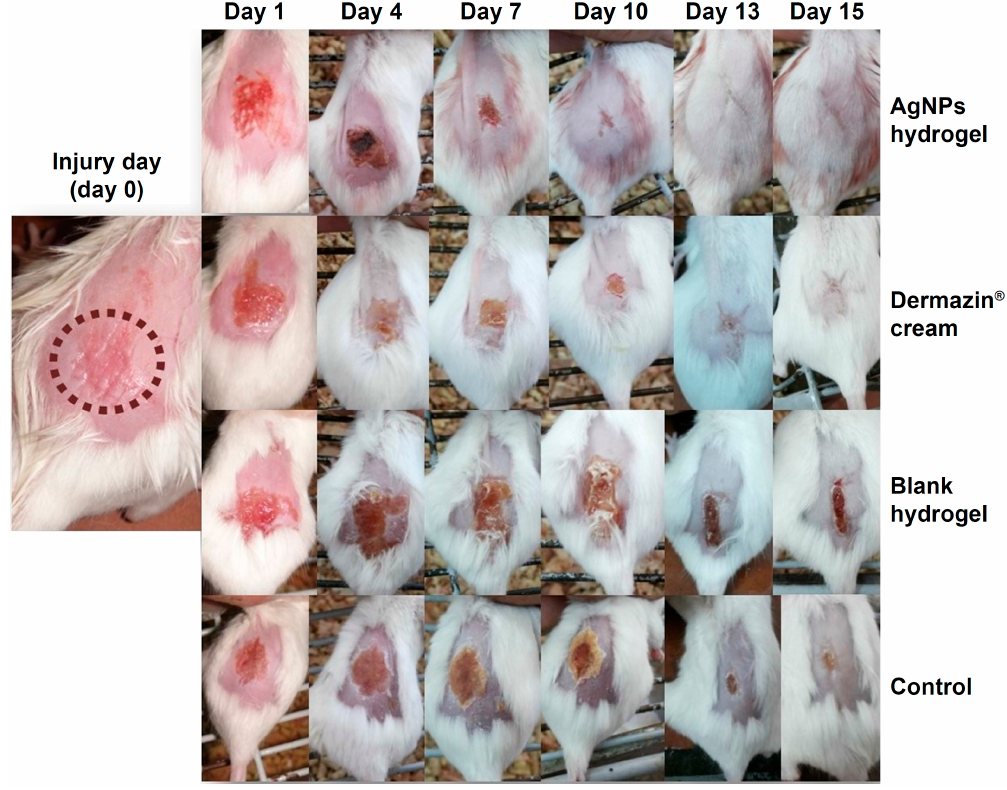
Figure 11. Successive images of representative mice skin abrasion wounds infected with MRSA at different time intervals. Two groups were treated with 0.1% silver nanoparticles (AgNPs) hydrogel and 1% silver sulfadiazine cream. The two other groups were the blank hydrogel-treated group and control untreated mice. Abbreviations: MRSA, methicillin-resistant Staphylococcus aureus ; AgNPs, silver nanoparticles. (Reprinted from reference [52]).